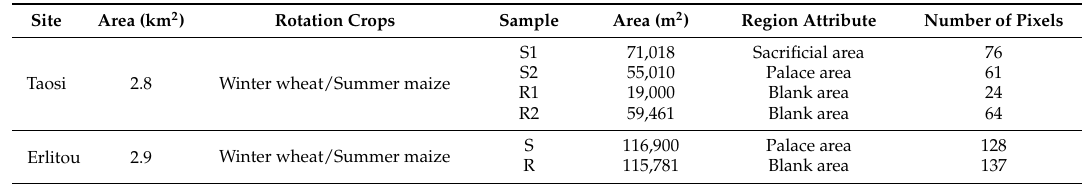
Figure 3. Location and attributes of the samples on the high spatial resolution images: ( a ) Taosi, 2 December 2010, Geoeye; ( b ) Erlitou, 30 December 2010, WorldView-2. Table 2. The main attribute of